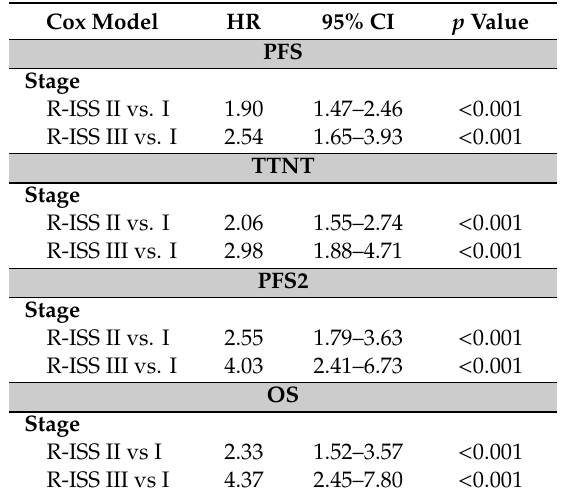
Figure 2. Outcome in patients receiving lenalidomide-prednisone (RP) vs. lenalidomide (R) alone: ( A ) progression-free survival (PFS); ( B ) time to next treatment (TTNT); ( C ) progression-free survival 2 (PFS2) and ( D ) overall survival (OS). Table 2. Multivariate Cox regression analysis of main baseline predictors of outcome in patients receiving lenalidomide-based